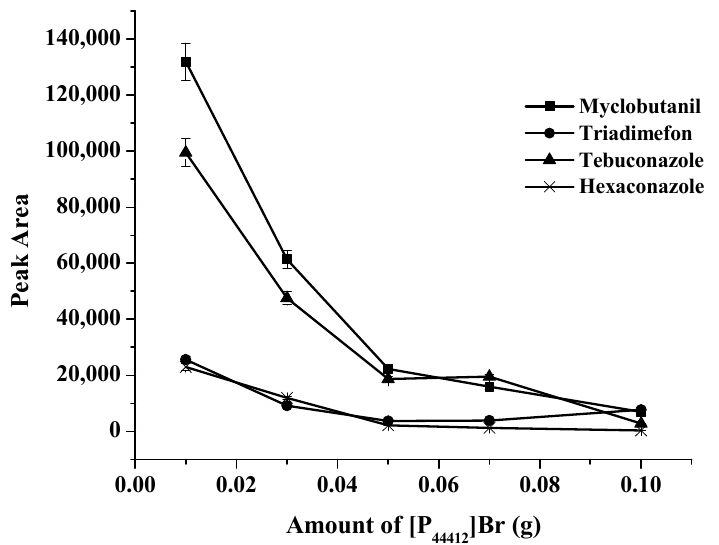
Figure 2. Effects of the amount of [P 44412 ]Br on the extraction efficiency. The amount of KPF 6 varied in a range of 0.01–0.10 g. The results are shown in Figure 3. The results showed that the maximum peak area was obtained at 0.01 g of KPF 6 . Then, the signal decreased at a higher amount of KPF 6. Thus, 0.01 g of KPF 6 was selected. The molar ratio of [P 44412 ]Br to KPF 6 was selected as 1:2.5 because the excess KPF 6 ensured 100% completion of the in situ metathesis reaction [24].